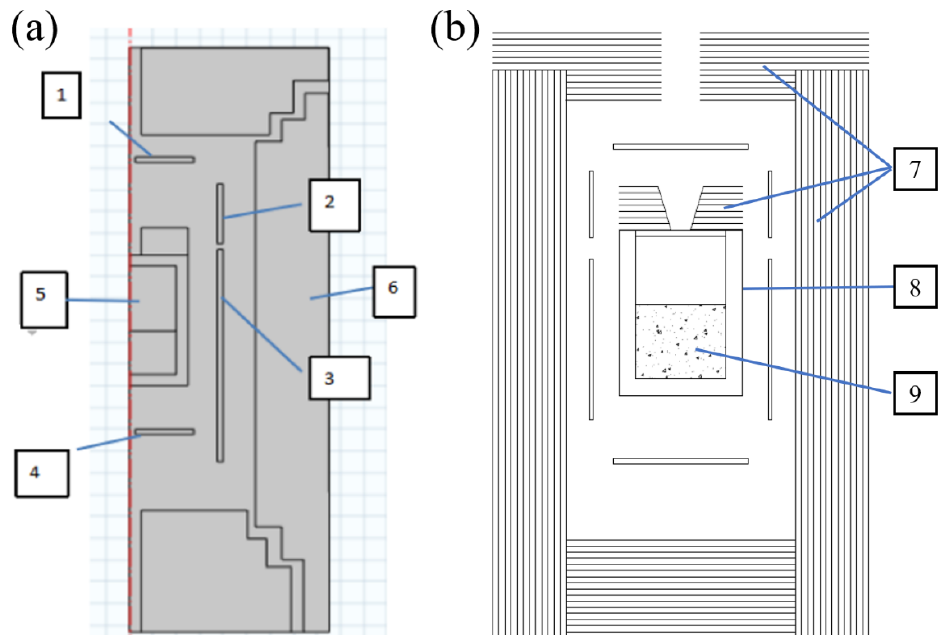
Figure 1. ( a ) Schematic diagram of different heater structures for AlN crystal growth resistance furnace. ( b ) Schematic diagram of tungsten and molybdenum thermal field structure for AlN crystal growth resistance furnace. 1—Top heater; 2—side heater 2; 3—side heater 1; 4—bottom heater; 5— growth chamber; 6 and 7— tungsten and molybdenum insulation screen; 8—tungsten crucible; 9— AlN raw materials.